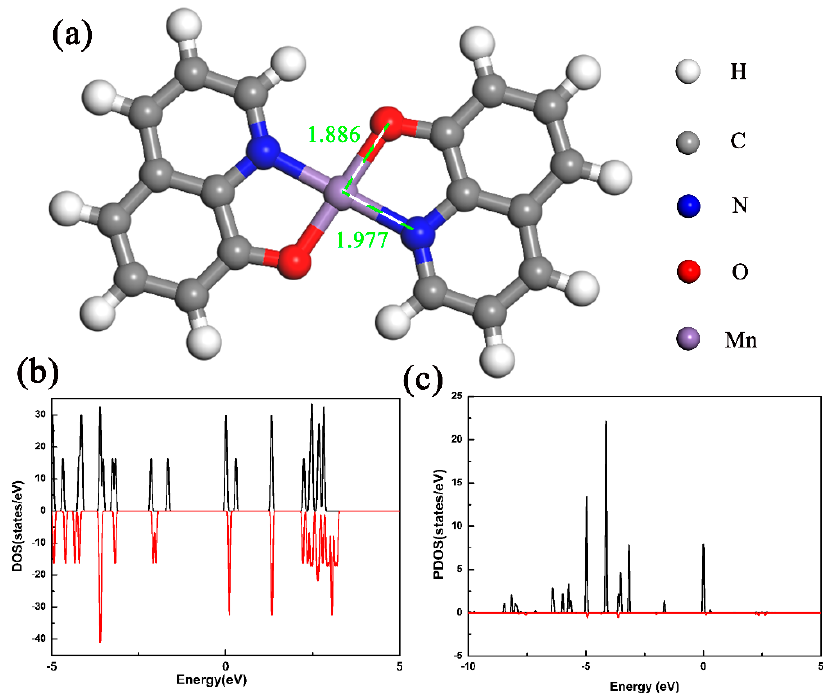
Figure 6. ( a ) The molecular structure of Mnq 2 molecule after full relaxation. ( b )The total DOS of the Mnq 2 isolated molecule. ( c ) The PDOS of the Mn 3 d orbital in the Mnq 2 isolated molecule.